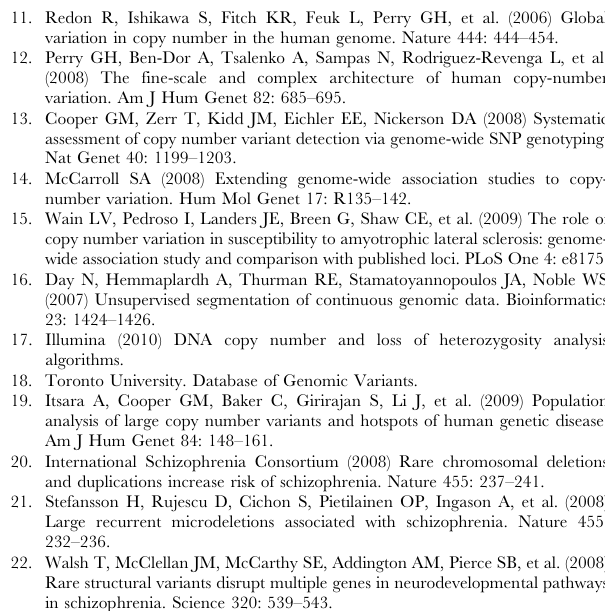
merged CNV groups vs. number of CNVs in the group, using the ‘‘40% either’’ overlap criterion, for CNVs reported in the literature for normal subjects. Figure S3 Number of CNVs per chromosome for CNVs reported in the literature for normal subjects, as well as number of CNVs based on merging overlapping CNVs. Figure S4 Distribution of CNV size for CNVs reported in the literature for normal subjects, as well as distribution of CNV size based on merging overlapping CNVs. Figure S5 Range of sizes of overlapping CNVs (within individual and chromosome) vs. chromosome for CNVs identified by requiring HMMSeg, cnvPartition with a 3-probe minimum, PennCNV, and QuantiSNP to all identify the CNV. N= 102 CNV groups (15 gains; 87 losses).